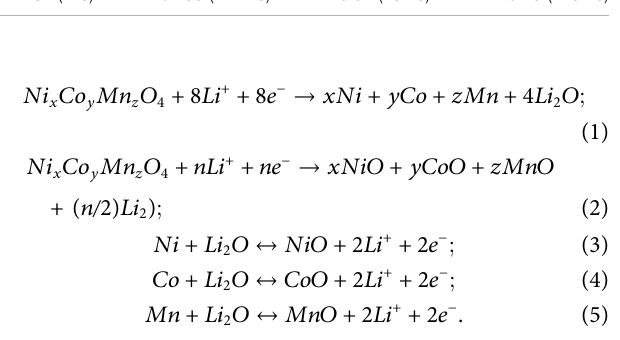
Frontiers in Materials |